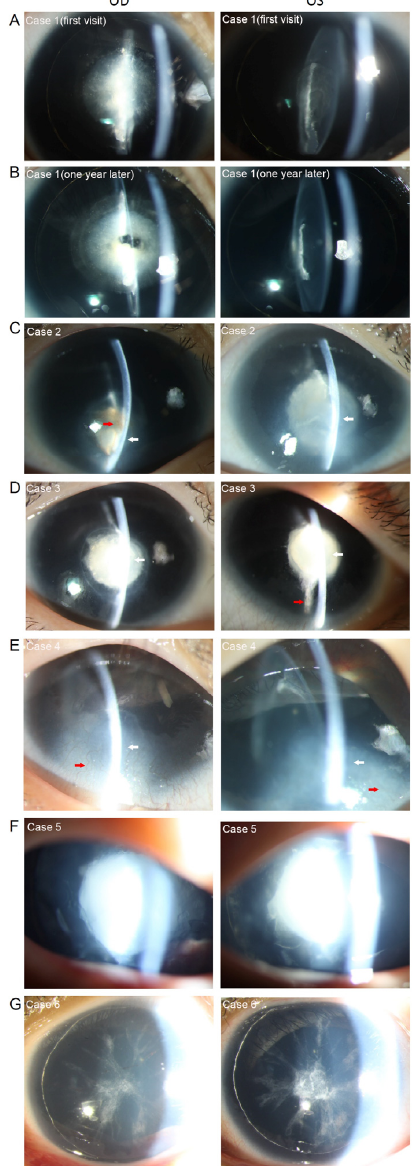
Figure 2. Anterior segment photographs of 6 patients with WAGR syndrome. ( A ). Anterior segment of case 1 at her first visit. ( B ). Anterior segment of case 1 one year later. ( C ). Anterior segment of case 2 showing keratolenticular adhesion, corneal neovascularization, aniridia, and cataract. ( D ). Anterior segment of case 3 showing keratolenticular adhesion, corneal neovascularization, aniridia, and the thin lens with cataract. ( E ). Anterior segment of case 4 showing keratolenticular adhesion, corneal neovascularization, aniridia, and the cataract. ( F ). Anterior segment of case 5 showing nu- clear cataracts and aniridia. ( G ). Anterior segment of case 6 showing subcapsular cataract and ani- ridia. (White arrow: keratolenticular adhesion; red arrow: corneal neovascularization.).